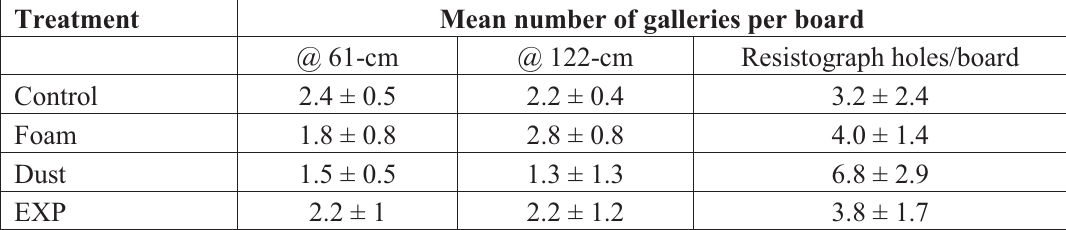
Table 2. Mean number of galleries per treatment location in boards by treatment type as determined by resistograph readings and number of resistograph drill attempts per board required to find at least one gallery for treatment.